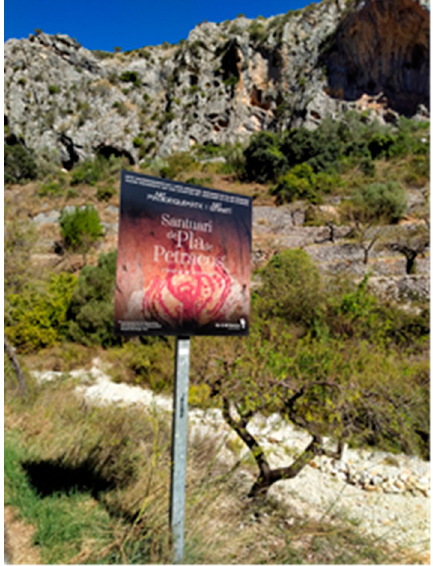
Figure 16. From t he river the paintings are visible. The photo is taken by the author. Figure 16. From the river the paintings are visible. The photo is taken by the